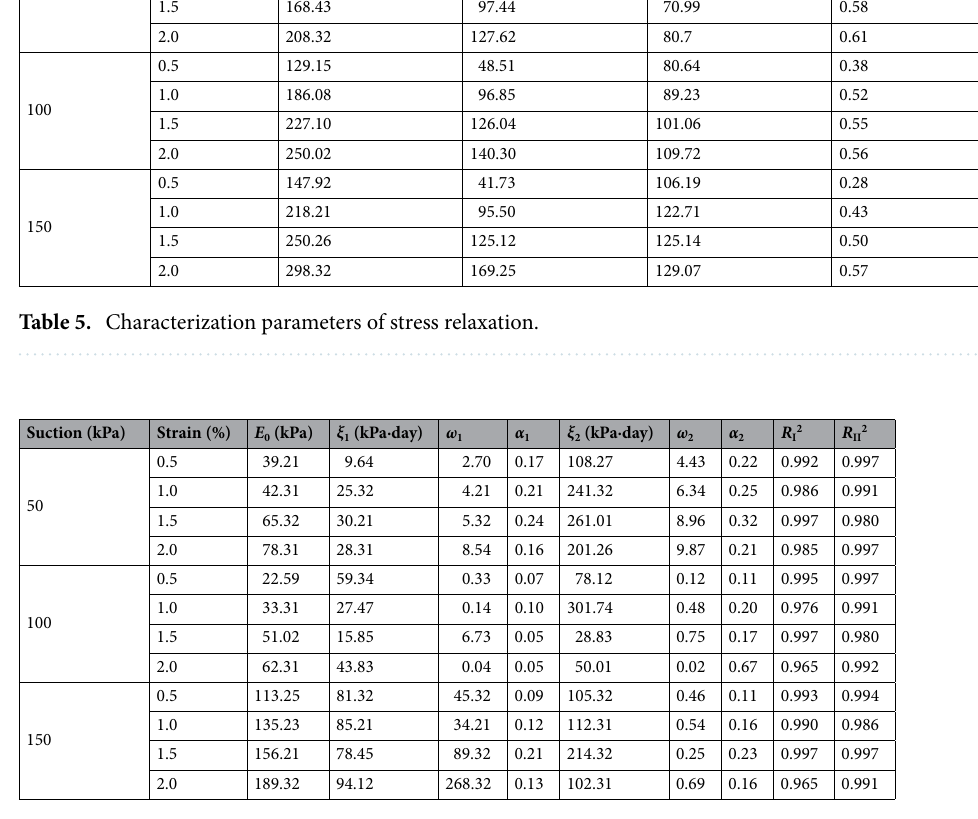
Table 6. Fitted parameter values for the proposed damage model.